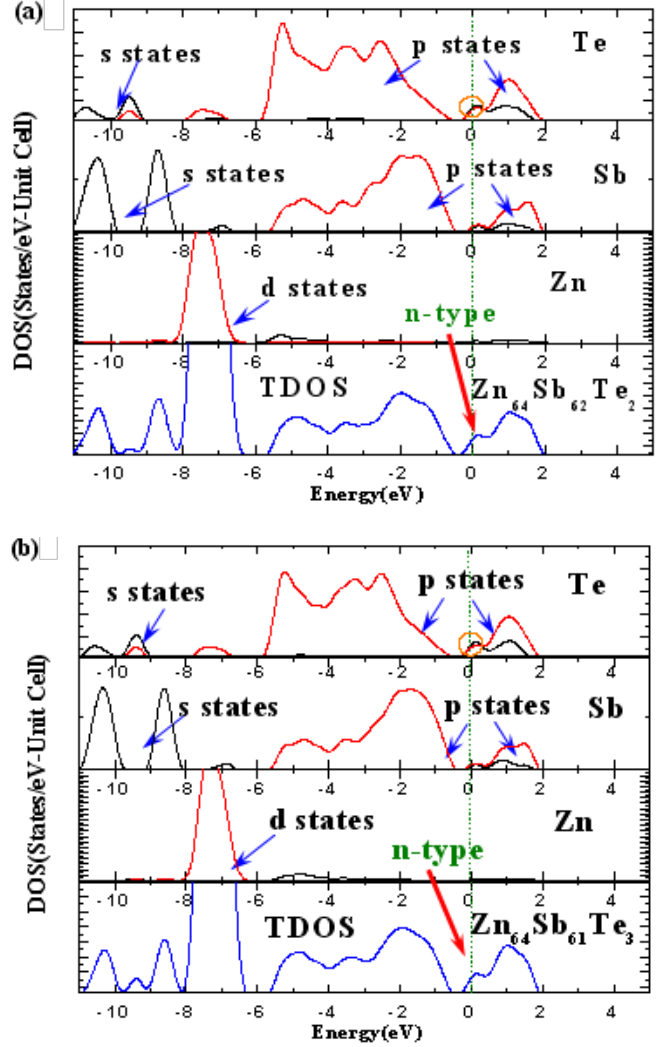
Figure 4. Total and partial densities of states of ( a ) Zn ( b ) Zn Sb Te (model S2) and ( c ) Zn 64 61 3